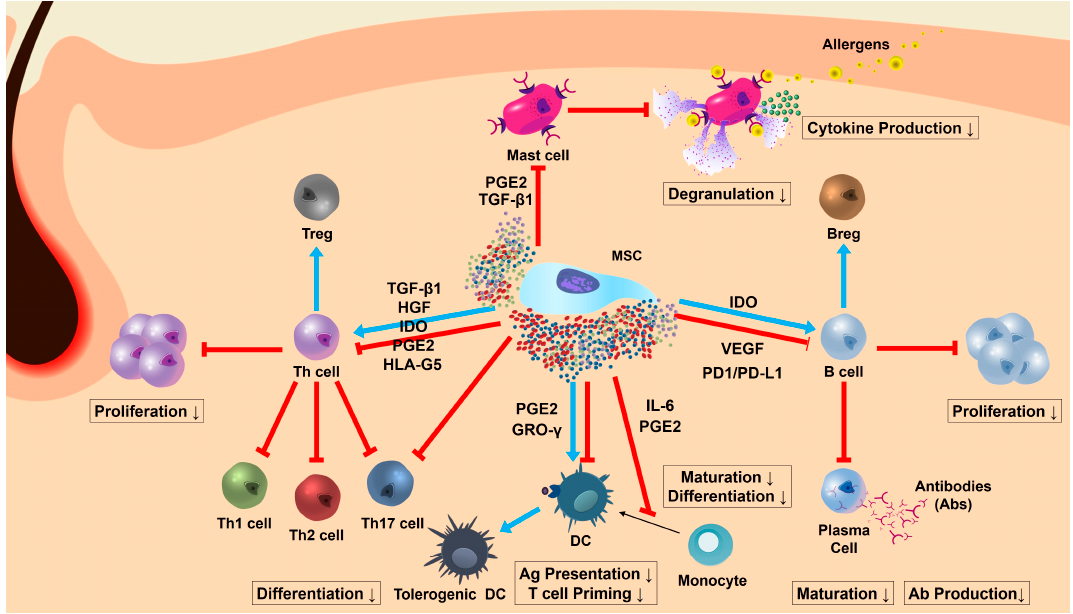
Figure 1. Mechanisms of MSC immunomodulation against principal inflammation-aggravating immune cells within inflammatory skin conditions. Red line: suppressive effect; Blue arrow: stimulatory effect.